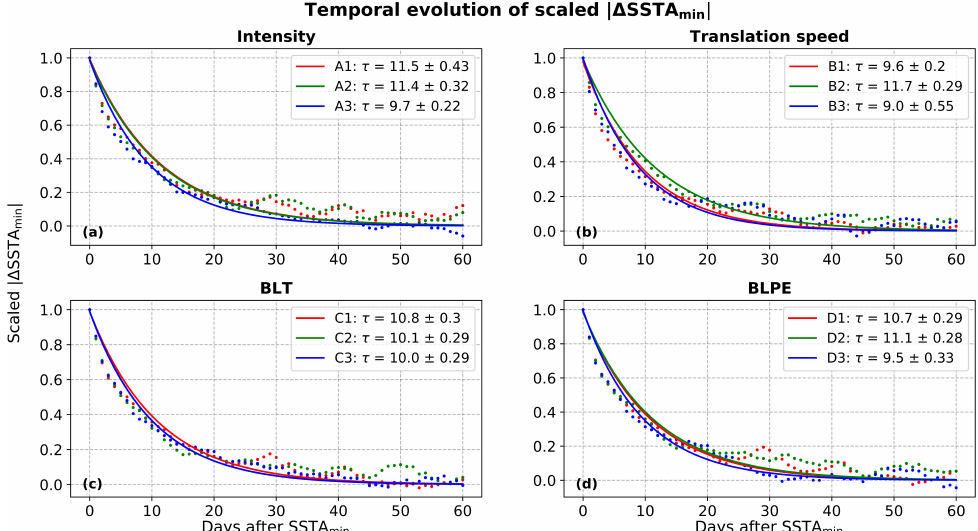
Figure 10. Mean composited time series of observed ∆ SSTA min obtained from the merged SST dataset after the passage of hurricanes scaled by their initial value (i.e., corresponding induced largest cooling). Observations are denoted by dots, while the exponential fittings by solid lines. Observations have been separated according to the individual parameters shown